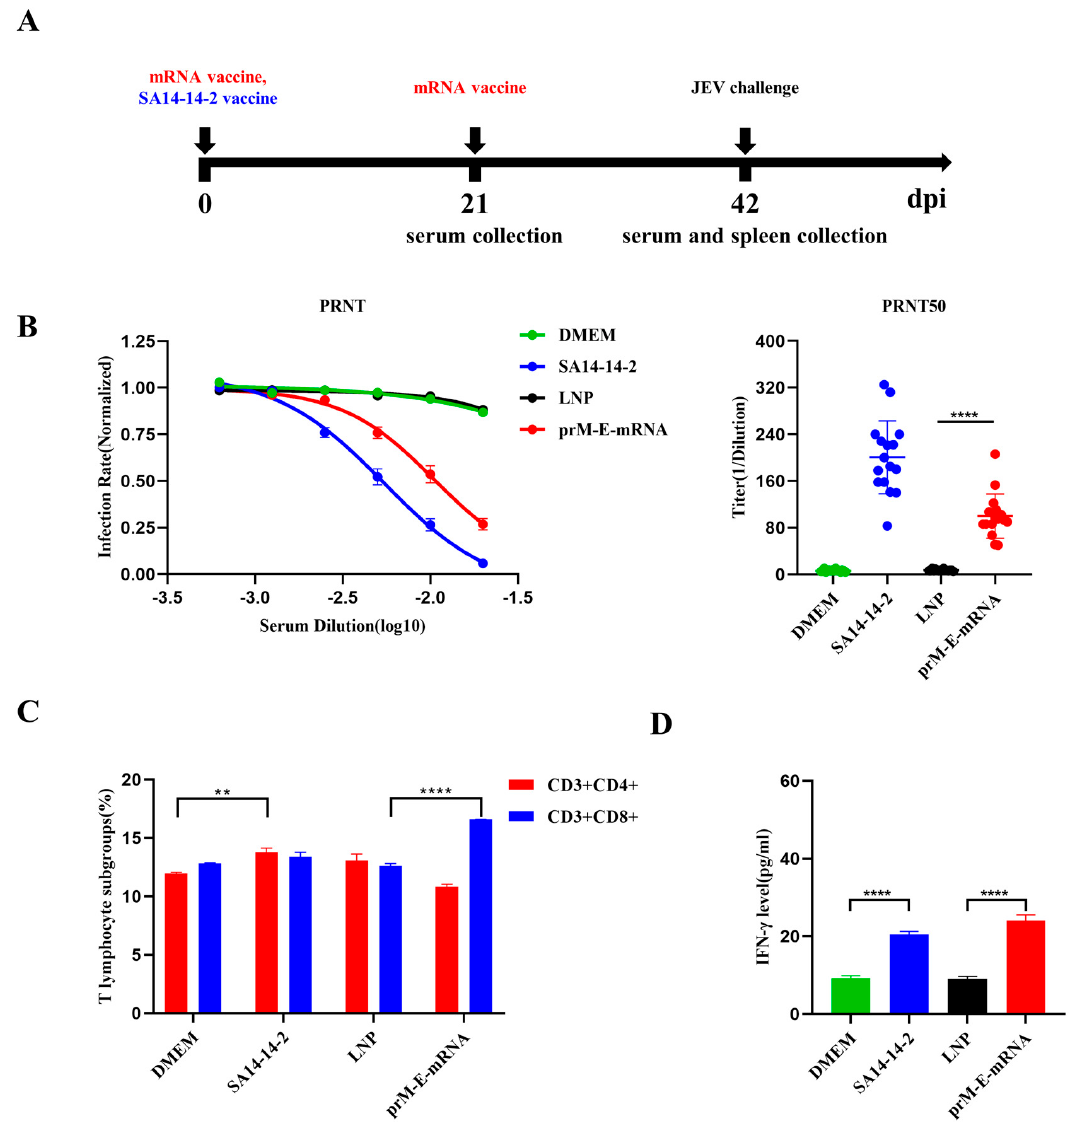
Figure 2. Immune responses in C57BL/6 induced by the mRNA-prM-E vaccine. ( A ) Mice were intramuscularly injected with 15 µ g of mRNA-prM-E or SA14-14-2 live-attenuated vaccine. The sera of mice in SA14-14-2 group and DMEM group were collected on day 21 while the sera of mice immunized with prM-E-mRNA or LNP were collected on day 42. ( B ) Serial dilutions of serum were tested for neutralization activity by PRNT assay. Neutralization curves (left panel) and the PRNT50 (right panel) are shown. Each experiment was independently repeated three times and PRNT50 was calculated by the Reed–Muench method ( n = 16, ** p < 0.01; **** p < 0.0001). ( C ) The percentages of CD8 + and CD4 + T cells in spleen were analyzed by flowcytometry. Data are represented as mean ± SEM of 3 spleens from 3 mice from each group. (** p < 0.01; **** p < 0.0001). ( D ) The IFN- γ level in sera was measured by ELISA. Data are represented as mean ± SEM. ( n = 16, ** p < 0.01; **** p < 0.0001).